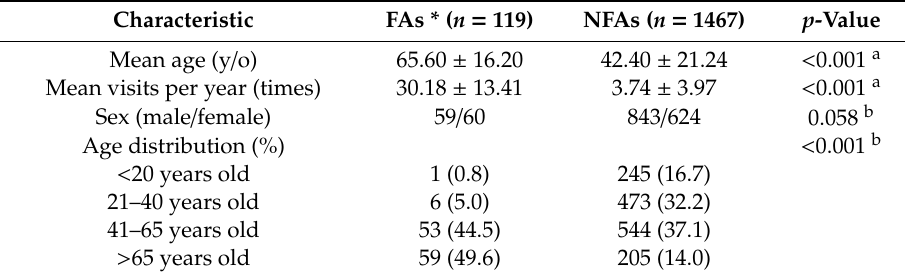
Table 1. Demographic data for all subjects ( n = 1586).